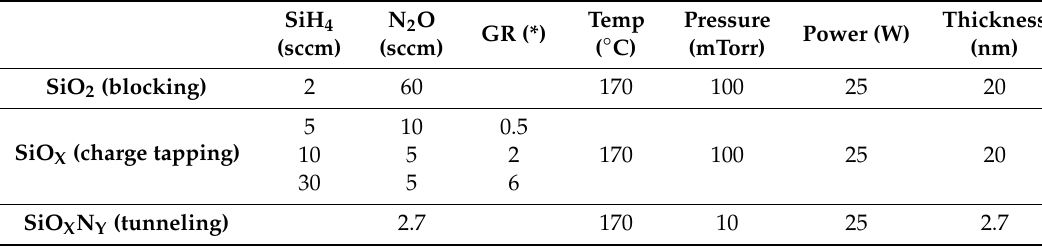
Figure 1. Schematic cross sections of ( a ) metal–insulator–silicon (MIS) (Ag/SiO 2 /SiO X /SiO X N Y /Si) capacitor, and ( b ) indium tin zinc oxide (ITZO) non-volatile memory (NVM) with a SiO 2 /SiO X /SiO X N Y stack. Table 1. Deposition condition for deposition of the SiO 2 / SiO X / SiO X N Y